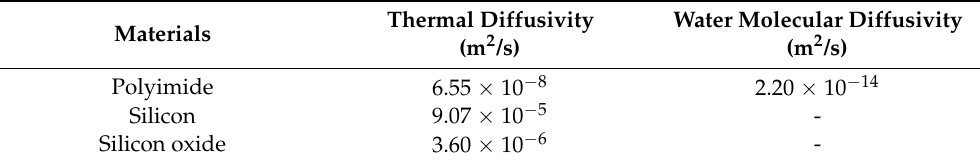
Figure 1. The medium and probe structure of the humidity sensor used in this paper. ( a ) The structure of the polyimide probe with comb-shaped electrodes. ( b ) The schematic diagram of the longitudinal section of the adjacent electrodes in the probe. Boundary 1 is the contact surface between the probe and the air. Boundary 2 is the symmetrical contact surface between the probe and the adjacent medium. Boundary 3 is the contact surface between the probe and the substrate passivation layer, Boundary 4 is the positive electrode passivation layer, and Boundary 5 is the negative electrode passivation layer. Table 1. Thermal diffusivity and molecular water diffusivity of some materials in polyimide-based capacitive humidity